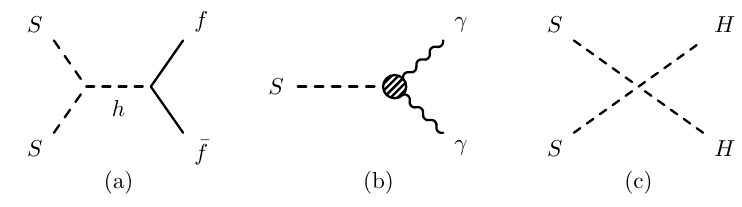
Figure 5 . Processes which connect S to the thermal